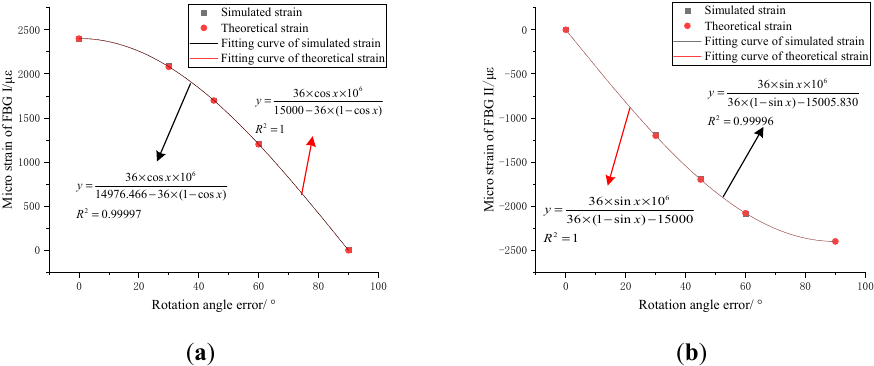
Figure 7. Relationship between FBG strain and rotation error angle in an orthogonal arrangement. ( a ) Micro strain fitting curve of FBG I; ( b ) micro strain fitting curve of FBG II .